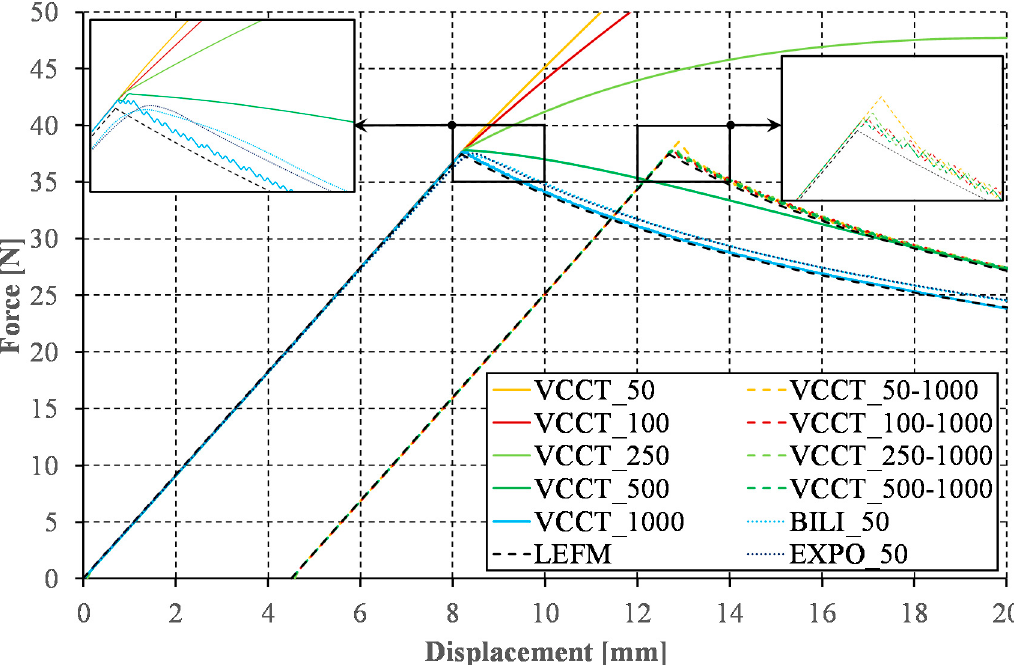
Figure 6. Influence of the substeps number on the load versus opening displacement curve.